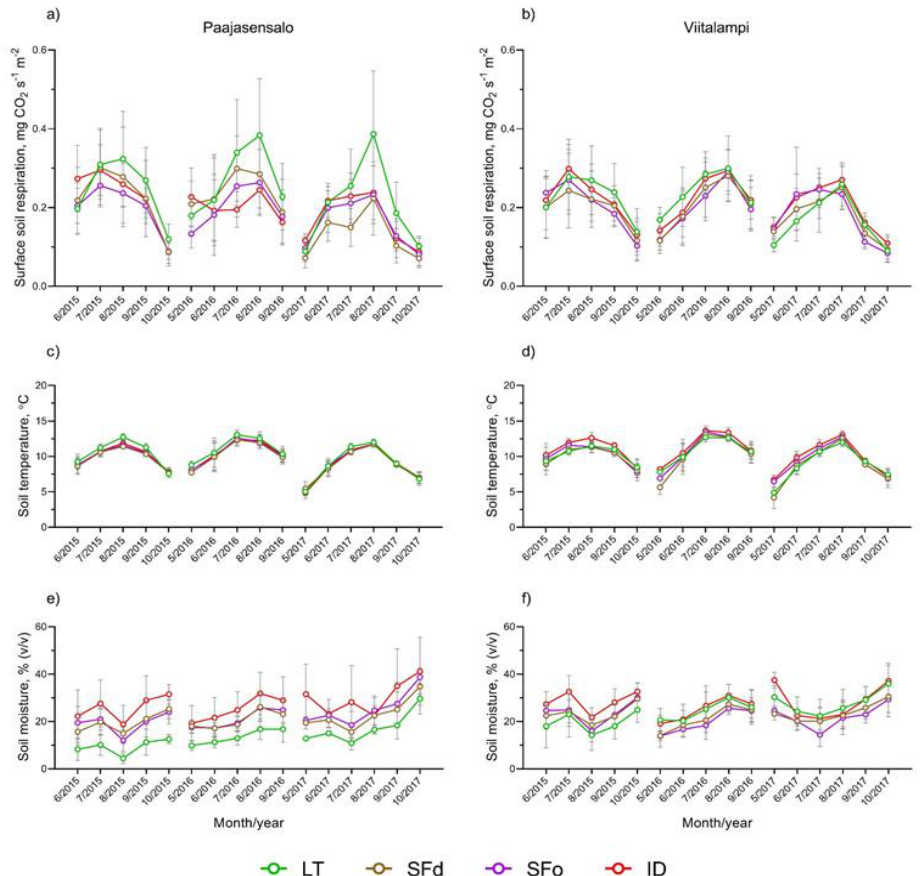
Figure 3. Monthly means and standard deviations for soil surface total respiration ( a,b ), soil temperature ( c,d ), and soil moisture ( e,f ) of each treatment in Paajasensalo (left) and Viitalampi (right). Values are based on measurements from the intact collars on plots established in 2015, i.e., the data set is consistent throughout 2015–2017. LT = living trees, SF d = storm dead tree detritus, SF o = storm open-vegetated, and ID = trees killed by I. typographus .